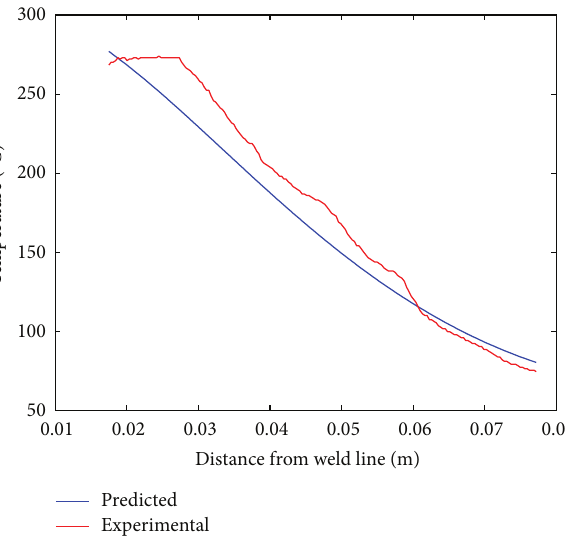
Figure 11: Temperature plot at 𝑡 = 85 sec along midline.